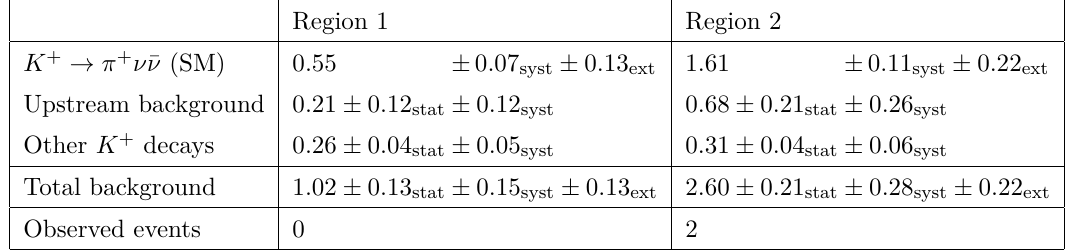
Table 1 . Summary of the predicted numbers of background events in the signal regions and the observed events. The statistical uncertainty for SM K + → π + ν ¯ ν is negligible and the external uncertainty arises from the uncertainty of the SM K + → π + ν ¯ ν branching